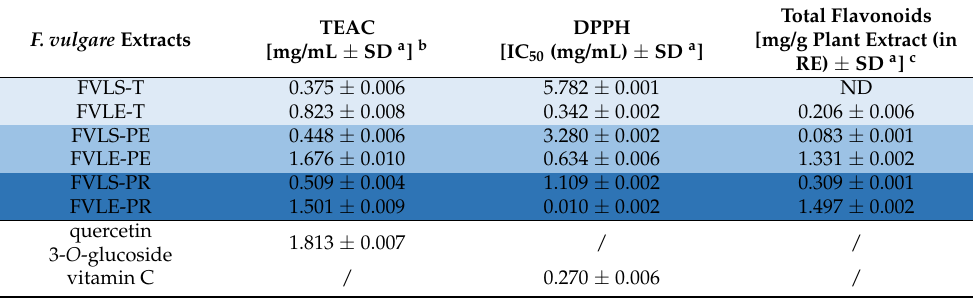
Table 3. Antioxidant activity of extracts of F. vulgare evaluated by TEAC and DPPH, Radical scaveng- ing activity assays, and the total amount of plant flavonoids of fennel.